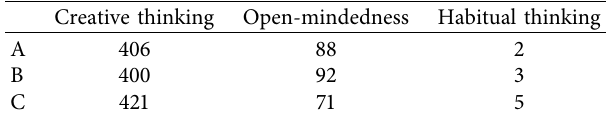
Table 2: Survey results of physical education students’ awareness of innovative thinking methods.